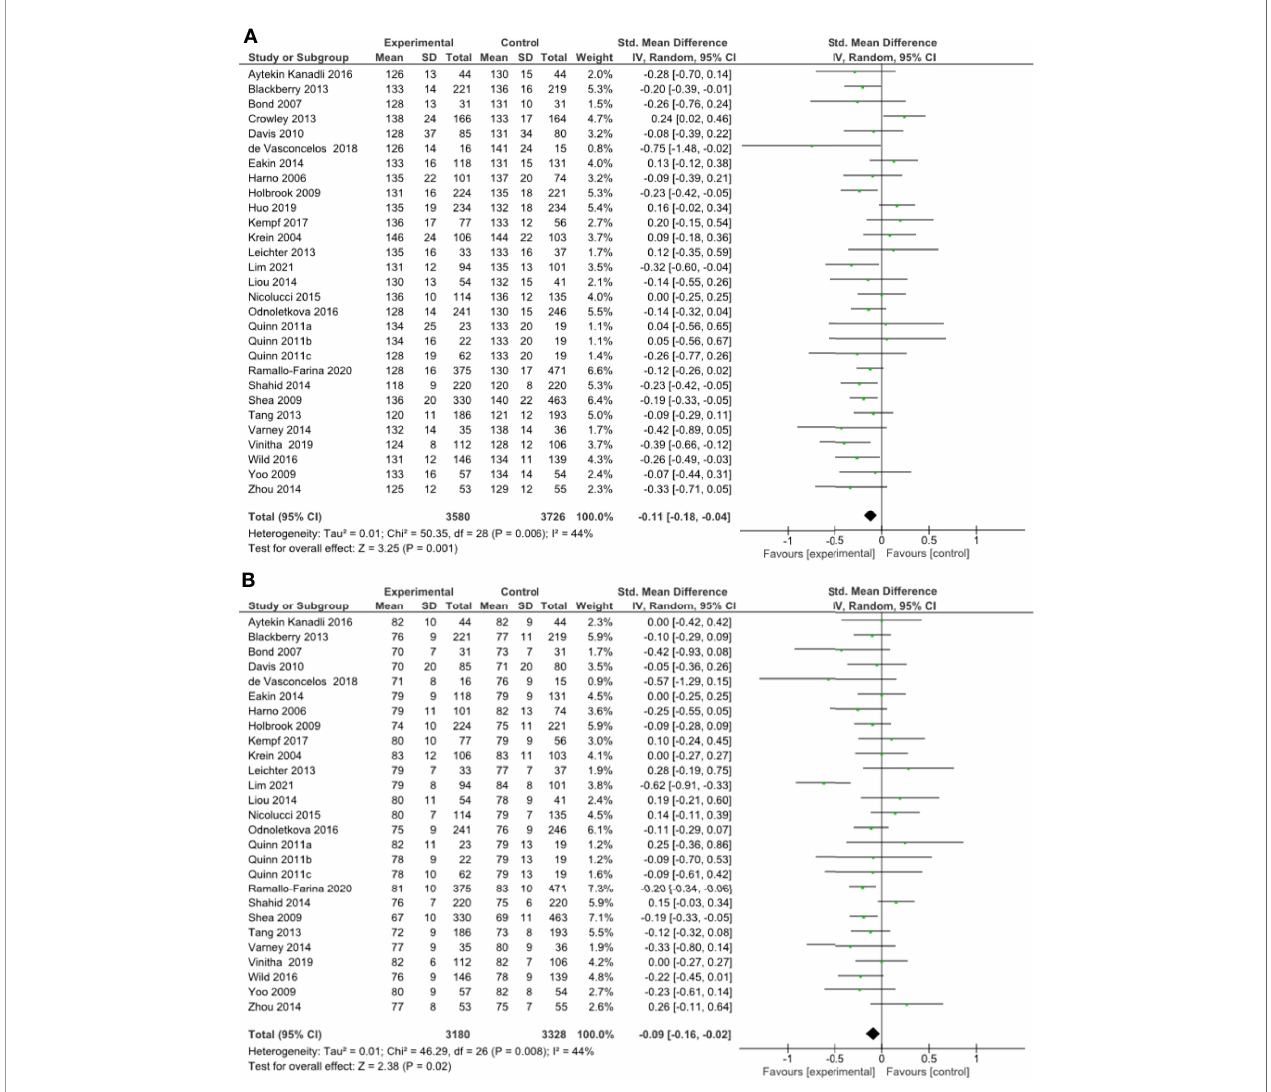
FIGURE 3 | (A) Forest plot showing the effect of remote management on systolic blood pressure, (B) Forest plot showing the effect of remote risk factor management on diastolic blood